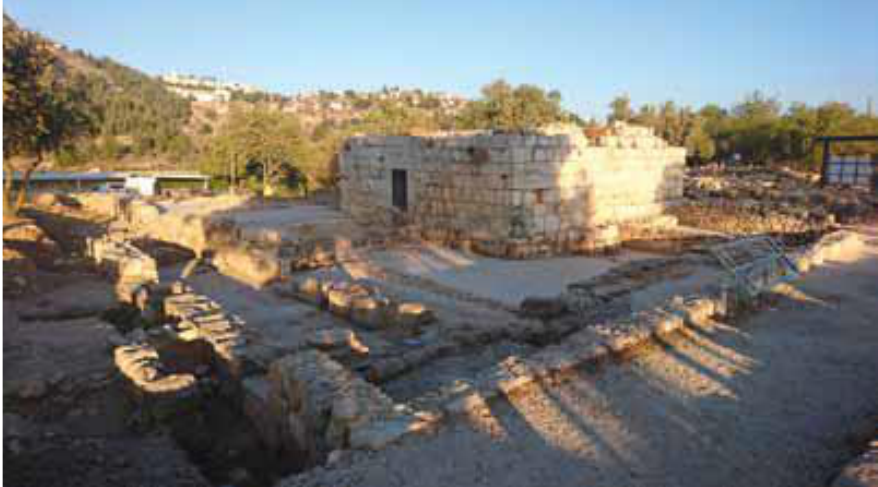
Figure 4. Current place of Jami ʿ al-Yatim , looking from northwest. Photo by the authors